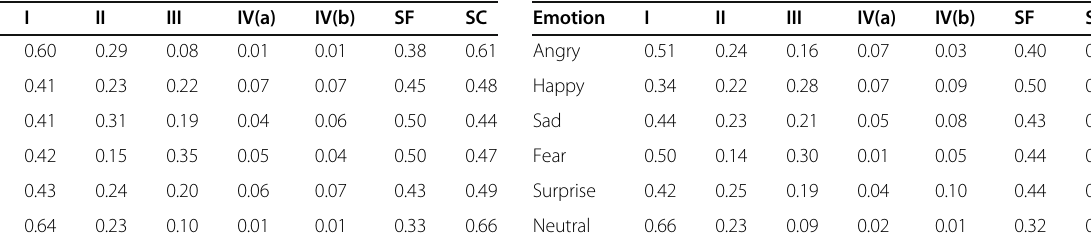
Table 3 The spatiotemporal transition of the LISA for the six emotions from day to night